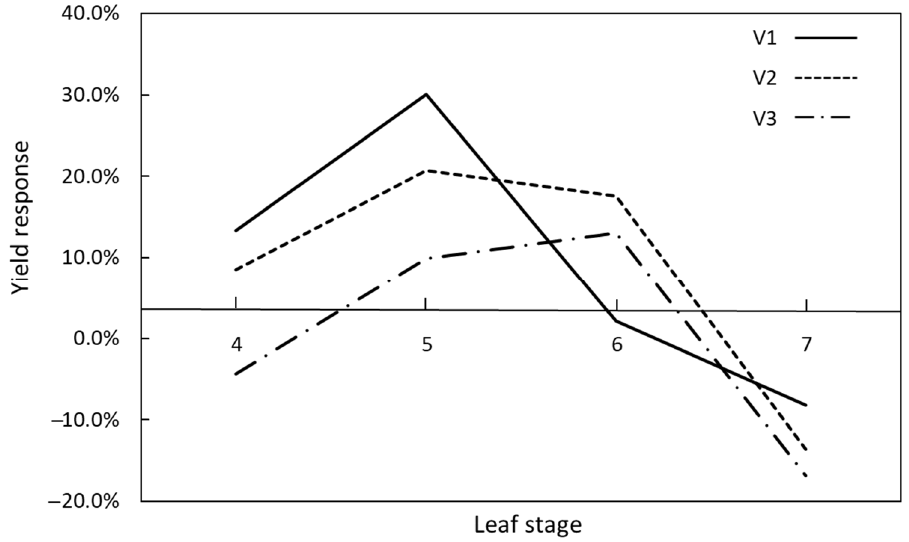
Figure 1. Response to defoliation conducted at different stages of plant development measured by leaf numbers. Results were obtained from three hybrids (V1 = Heyu187; V2 = Yuhe988; and V3 = Chengyu13) defoliated at four time points (from D4 to D7 leaves). Data used for this figure were reported by Pang et al. 2016 [41].